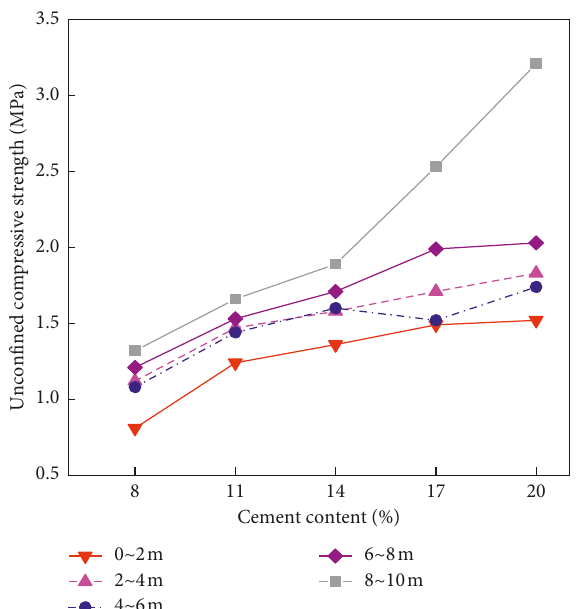
Figure 2: Influence of cement content on the unconfined com- pressive strength.